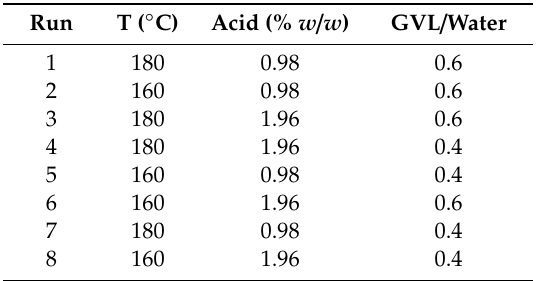
Table 1. The design of experiment (DoE) for the organosolv (OV) pre-treatment of raw material (RM). Run T ( ◦ C) Acid (% w / w ) GVL / Water 1 180 0.98 0.6 2 160 0.98